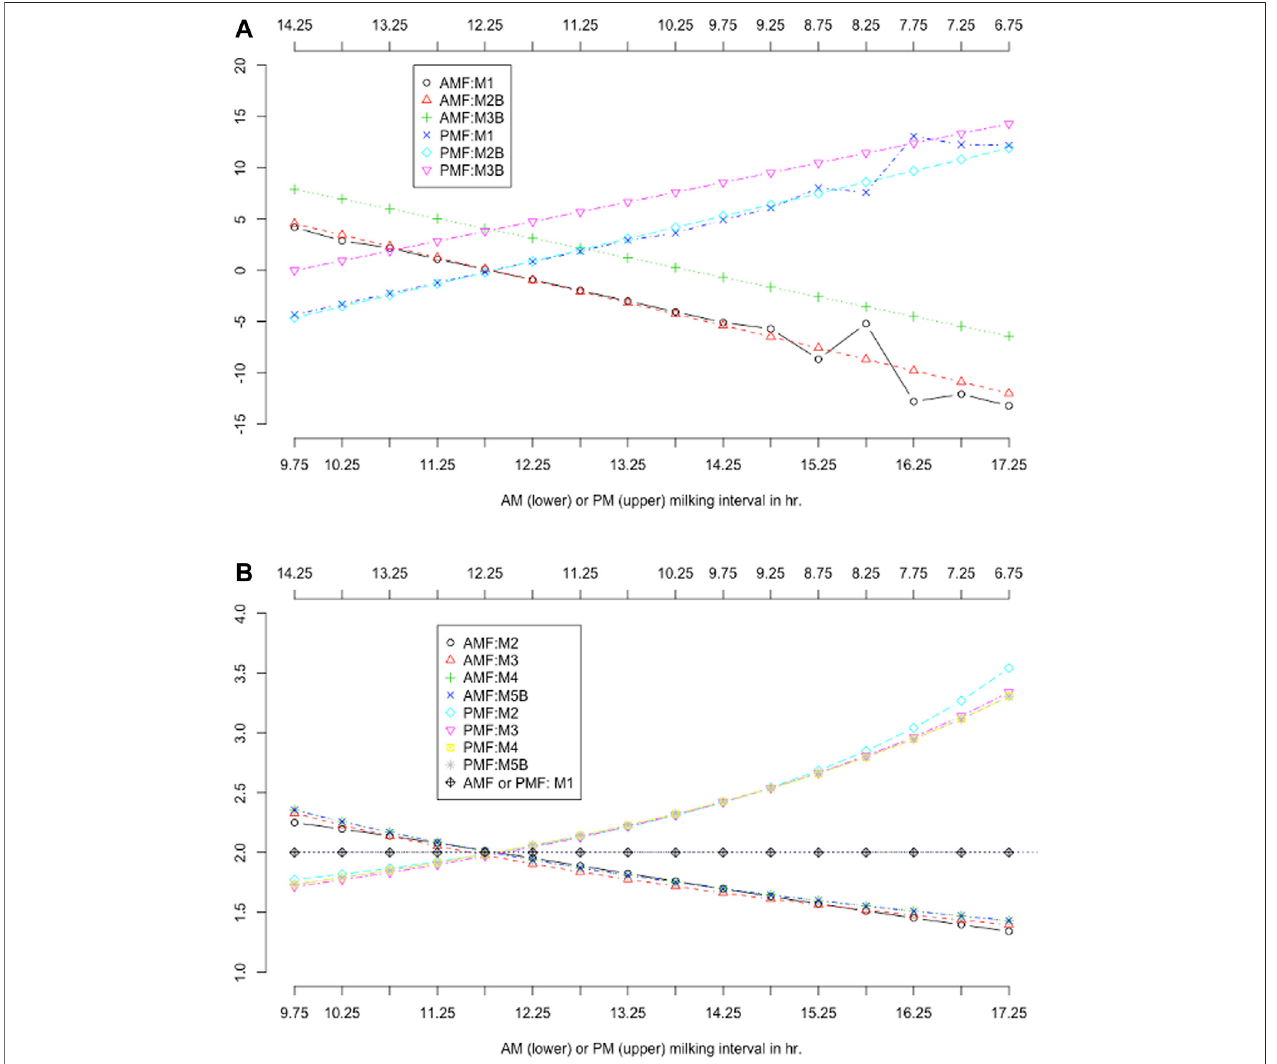
FIGURE 7 | Comparison of additive correction factors (A) and multiplicative correction factors (B) obtained using different models. AMF = morning milk yield correctionfactors; PMF=eveningmilkyieldcorrectionfactors. M0=dailymilkyield(DMY)estimatedastwotimesAMorPMyield;M1=additivecorrectionfactors(ACF) model with categorical milking interval (MIC) and lactation months; M2B = ACF model with continuous milking interval and days in milk (DIM); M3B = linear regression of DMYonmilkingintervalandDIM,withACFscomputedfordiscretizedMIC;M5=multiplicativecorrectionfactor(MCF)modelaccordingtoShooketal.(1980);M6= MCF model according to DeLorenzo and Wiggans (1986); M7B = MCF model according to Wiggans (1986); M8B = MCF model based on the exponential regression model (Wu et al., 2022).